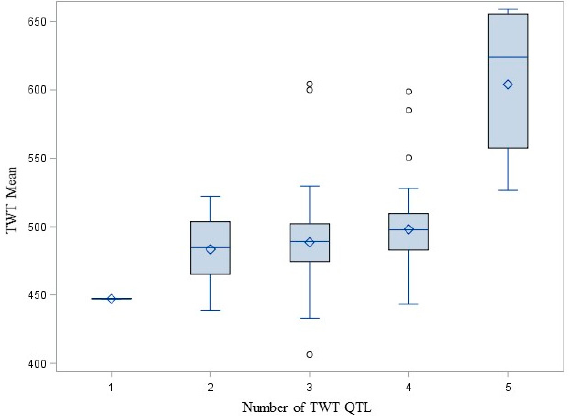
Figure 3. Box and whisker plot showing the mean, quartiles, maximum and minimum TWT means